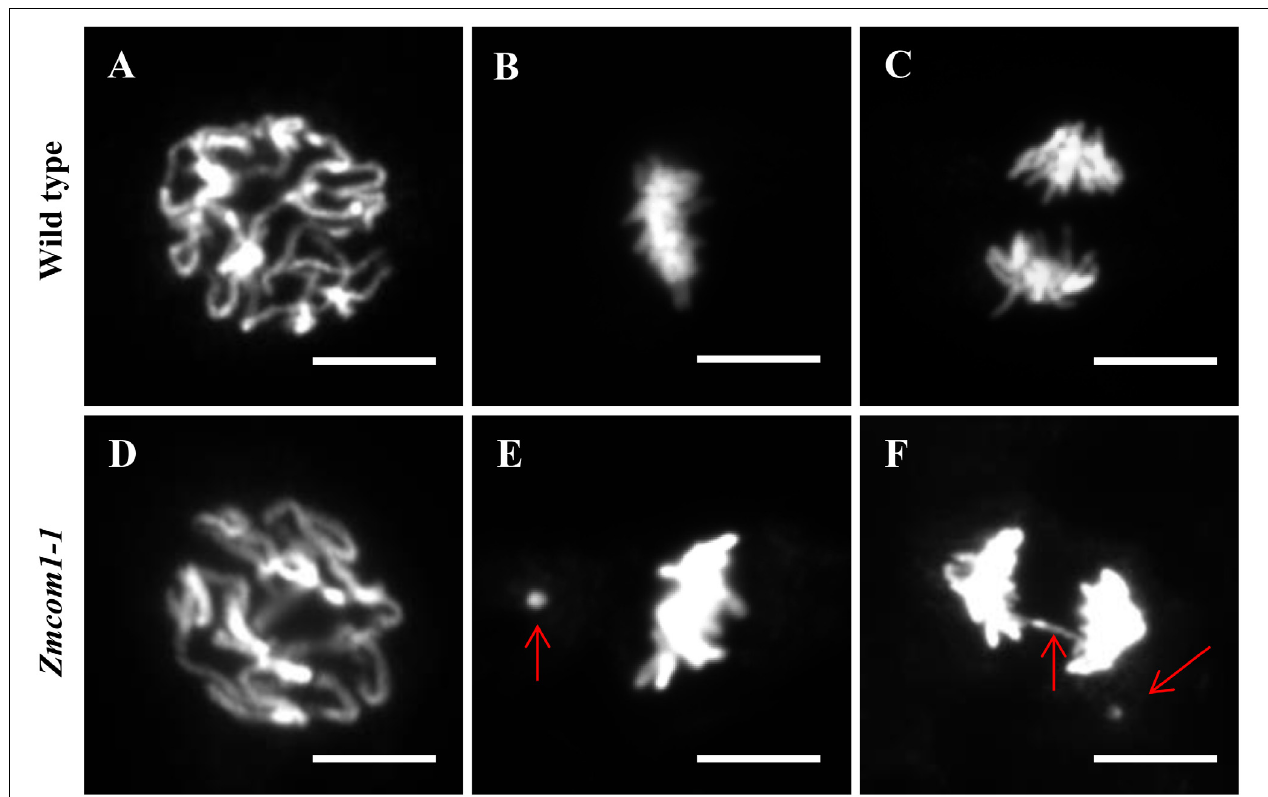
TABLE 1 | Genome Instabilities in wild type and Zmcom1 mitotic cells. Metaphase Anaphase No. of cell No. (percentage) of cell scored appearing fragment